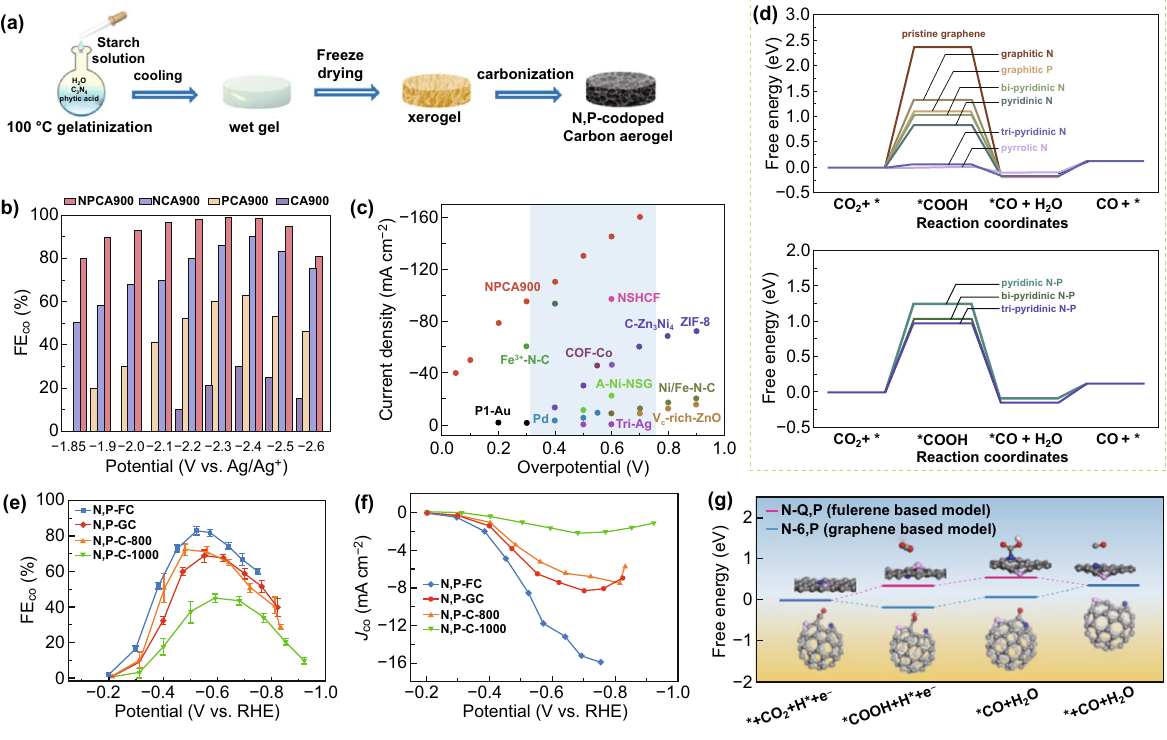
Fig. 5 Heteroatom doping in carbon materials. a Schematic illustration of NPCA synthesis. b FE CO for various catalysts. c Current density over NPCA900 compared with other catalysts. d Gibbs free energy diagrams for ECR–CO over simulated N- or P-doped carbon configuration